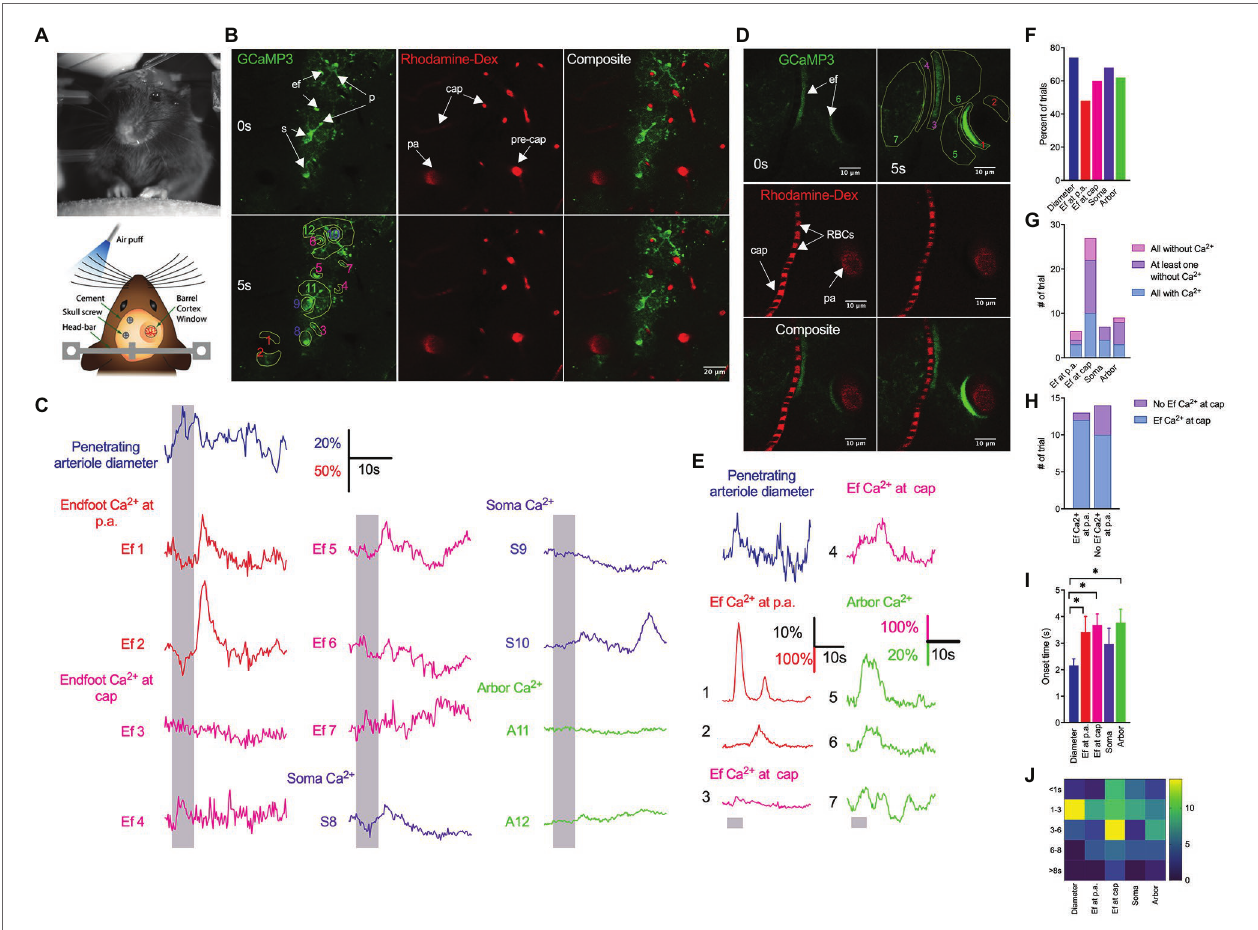
FIGURE 1 | Contralateral whisker stimulation predominantly elicits reliable arteriole dilation but generates heterogeneous astrocytic Ca 2+ responses. (A) Image of an awake mouse and schematics showing the in vivo experimental setup. (B) Representative images from a cranial window over the barrel cortex of a GLAST-Cre ERT x GCaMP3 mouse showing Ca 2+ fluctuations (green) from endfoot (ef), soma (s), process (p) and vessel response in penetrating arterioles (pa), pre-capillaries (pre-cap) and capillaries (cap) [labeled with Rhod-B dextran (red)] before (top images) and during (bottom images) a 5 s whisker stimulation. Regions of interest (ROIs) (bottom left) correspond to representative traces in (C) . (C) Representative traces from a GLAST-Cre ERT x GCaMP3 mouse (from ROIs as indicated in B ) showing the percent change in peak diameter of a penetrating arteriole (navy) and Ca 2+ activity from an endfoot at the penetrating arteriole (red), endfoot at the capillaries (magenta), soma (purple), and arbor (green) in response to a 5-s whisker stimulation. Vertical shaded areas indicate periods of whisker stimulation. (D) Higher-magnification images of a penetrating arteriole and nearby capillary enveloped by an astrocytic endfoot from a different mouse showing responses immediately prior to (0 s) and during (5 s) whisker stimulation. ROIs (top right) correspond to representative traces in (E) . (E) Representative traces showing changes in penetrating arteriole diameter change and astrocytic Ca 2+ fluctuations (from ROIs as indicated in D (top right)) in different subcellular compartments in response to whisker stimulation. (F) Plot showing the percentage of trials generating arteriole dilation and Ca 2+ increases in response to a 5-s whisker stimulation. (G) Summary showing the number of trials that displayed Ca 2+ changes in all, all but one (at least one) or none from a given subcellular structure among several astrocytes observed within a single field of view. (H) Summary showing heterogeneity of Ca 2+ increases observed at endfeet wrapping around the penetrating arterioles and those enwrapping capillaries when they were imaged simultaneously. (I) Summary showing arteriole dilation onset time and that of Ca 2+ changes in all subcellular compartments of the astrocyte in response to a 5 s whisker stimulation. (J) Heat map showing the distribution of onset time of arteriole dilation and Ca 2+ changes in all subcellular compartments of the